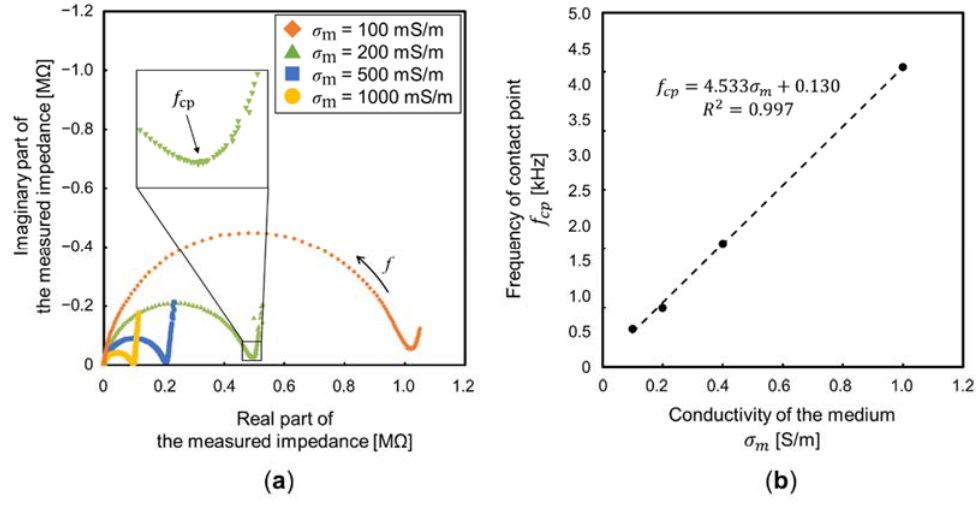
Figure 11. Measurement results of the proposed device. ( a ) Complex impedance locus with different σ m . The diameter of the semi-circle is proportional to the σ m − 1 . ( b ) The frequency, which is the contact point between the semi-circle by the medium and locus by the EDL against σ m .